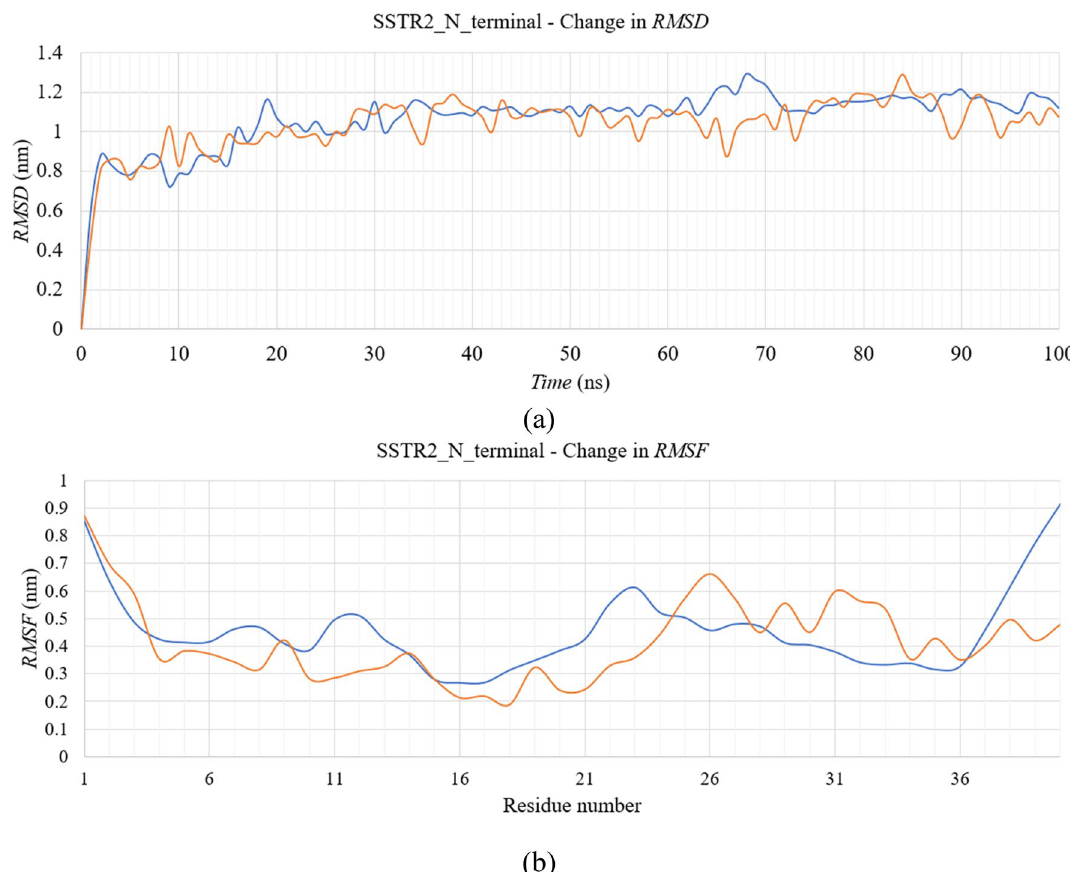
Figure 7. Time evolution of ( a ) RMSD and ( b ) RMSF of SSTR2 N-terminal domain in the presence or absence of the lipid bilayer. Systems with presence and absence of DPPC bilayer are represented as blue and orange lines,